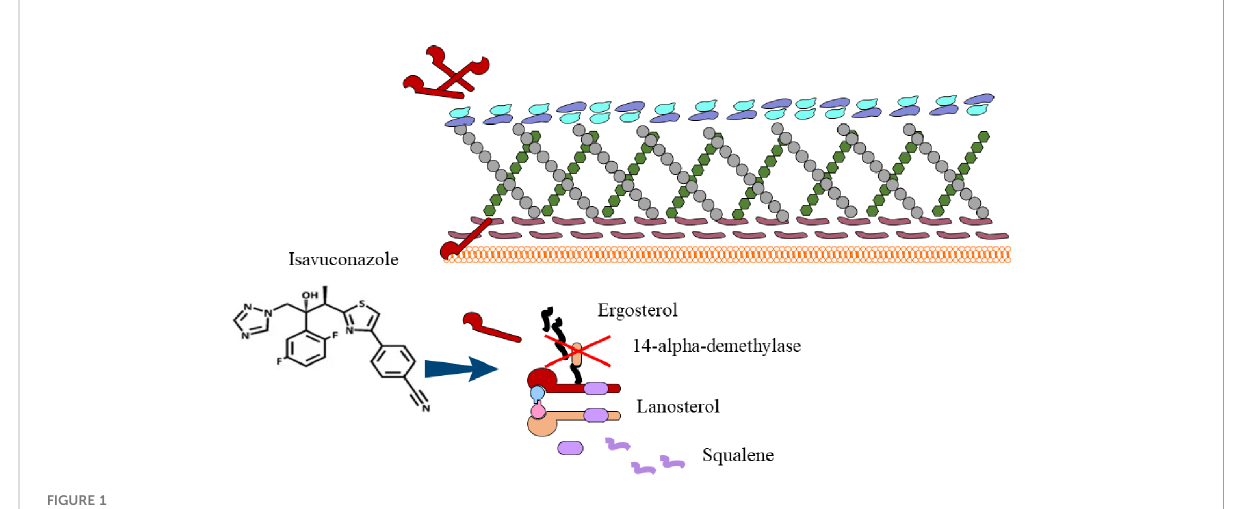
FIGURE 1 The chemical structure of ISA and its antifungal